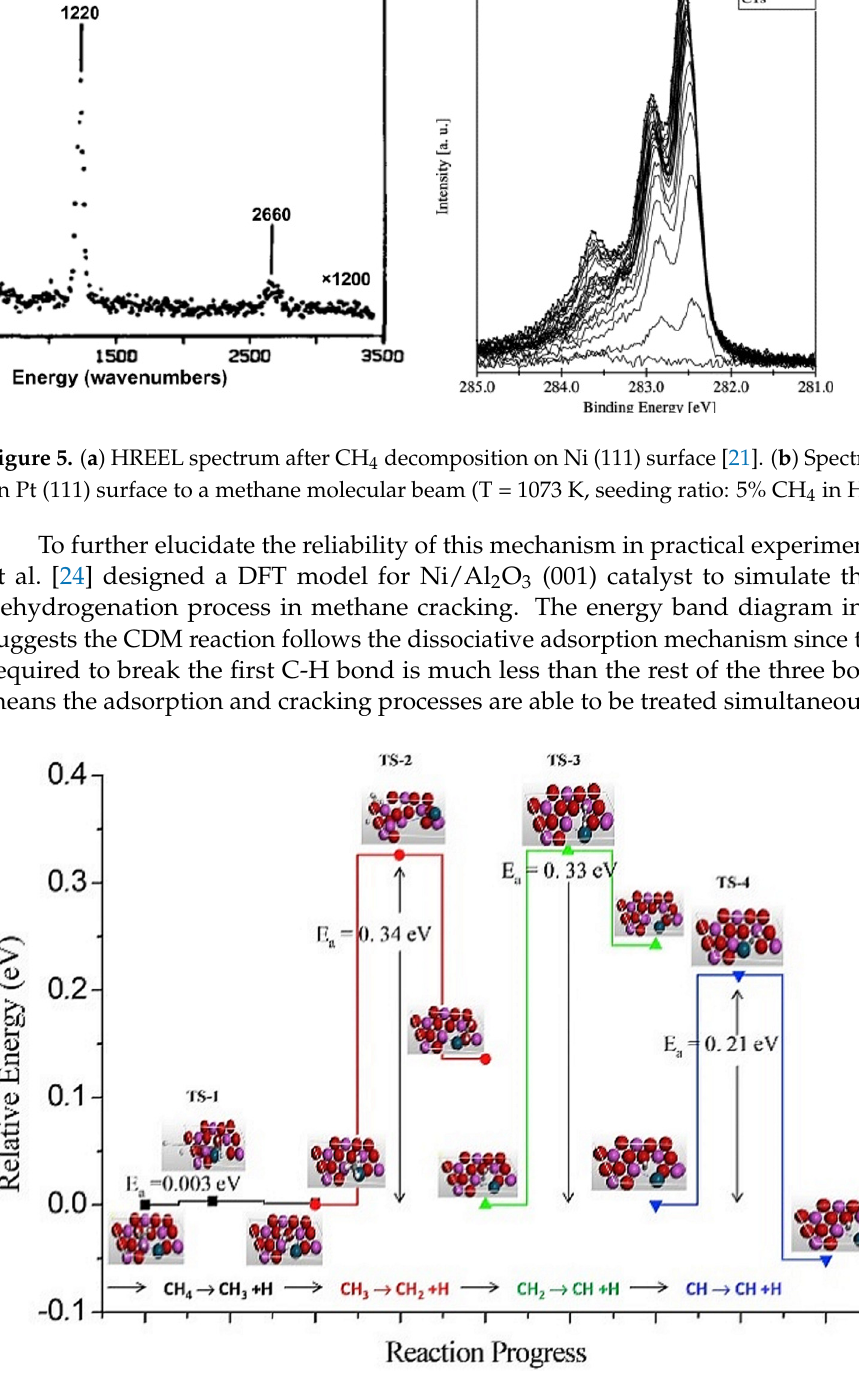
Figure 6. DFT model of progressive catalytic methane cracking on Ni/Al 2 O 3 (001) surface (I means the concentration of vacant sites.) [24].